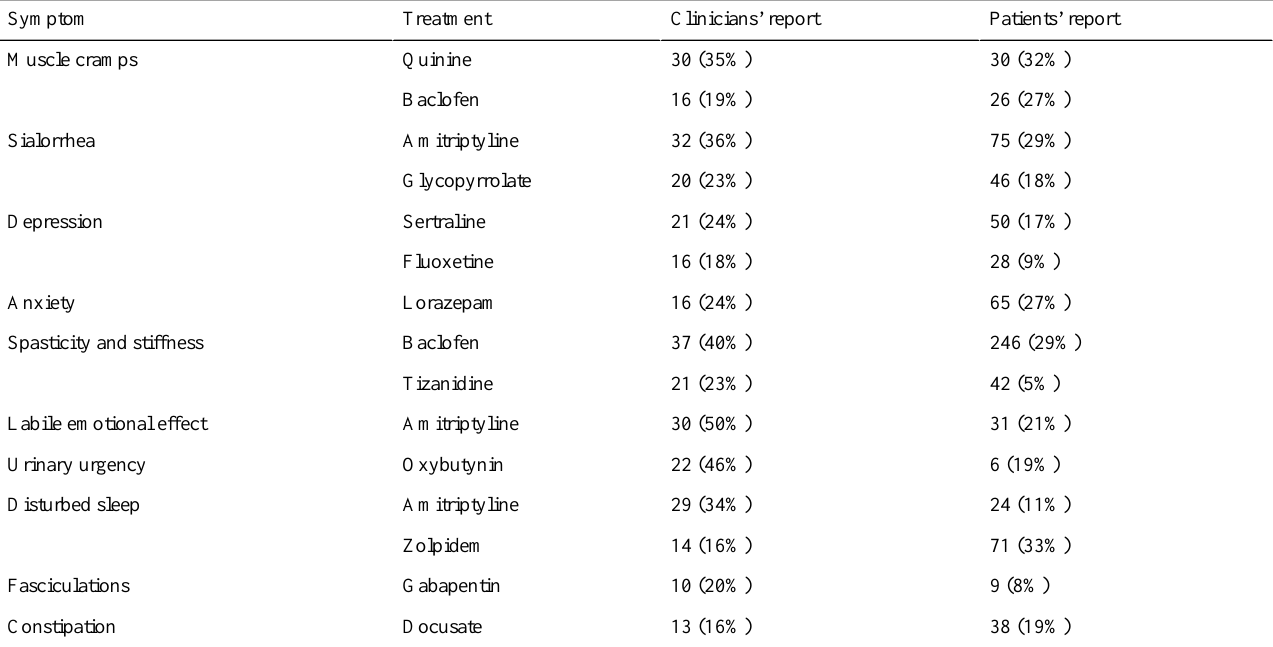
Table 2. Comparison of percentage of clinicians reporting preferences for specific treatment use in response to a symptom, and patient-reported usage of the same